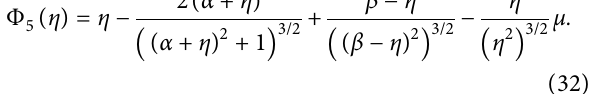
� m � m ) : (a) equilibrium solutions on η − axis and the red curve corresponds to the solutions of Φ 1 2 3